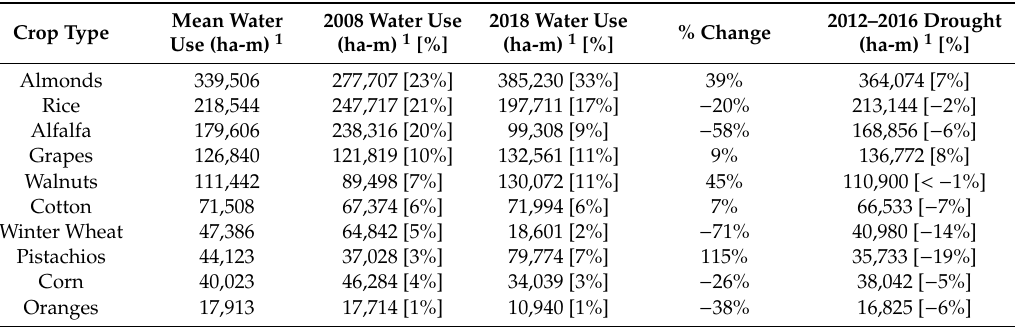
Table 4. Volumetric water use estimates for the top 10 major crops in the Central Valley from 2008 to 2018 ordered by the mean including: (1) the 2008–2018 mean water use, (2) the water use in 2008 including the percentage of the total, (3) the water use in 2018 including the percentage of the total, (4) the % change in crop water use between 2008 and 2018, and (5) the mean crop water use during the 2012–2016 California drought and percent deviation from the mean.